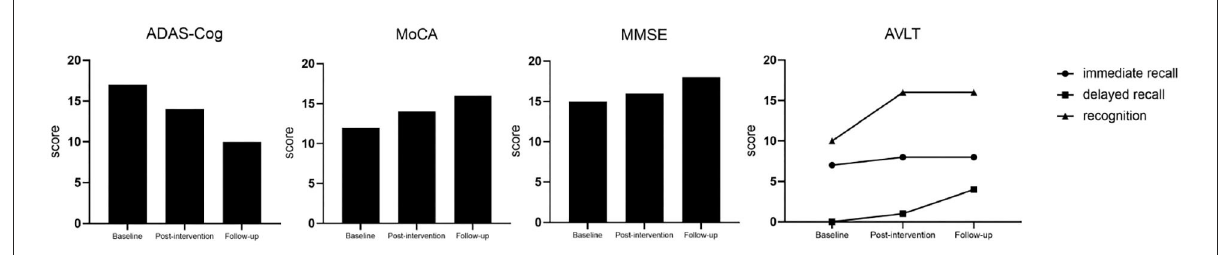
Reference Participants and design